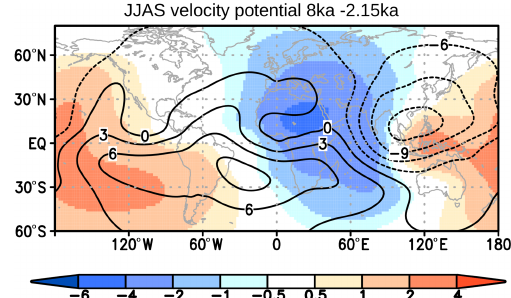
Figure 11. Simulated difference (shaded) in June–September mean upper-tropospheric (250hPa) velocity potential (km 2 s − 1 ) between the time slice at 8ka and 2.15ka. Bluish colour indicates enhanced divergence, coinciding with vertical ascent in the troposphere be- low; reddish colour indicates stronger convergence, coinciding with subsidence below. The contours plotted on top show the respective velocity potential at 2.15ka. Negative values display divergence and positive values